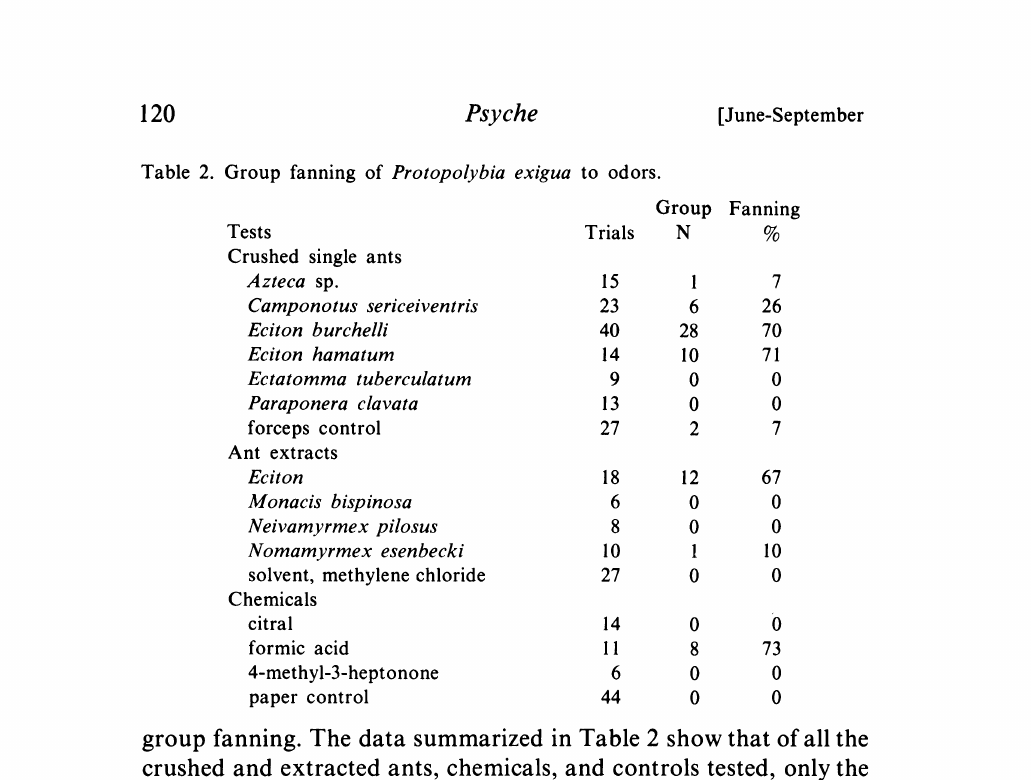
Table 2. Group fanning of Protopolybia exigua to odors. Tests Trials